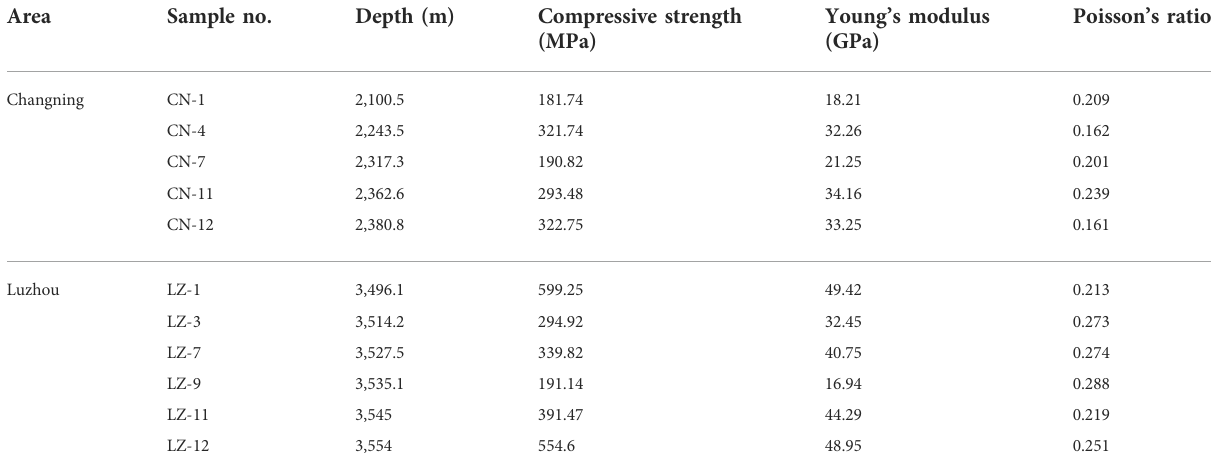
TABLE 2 Test results of triaxial compression experiments of the longmaxi formation shale in the study area. Area Sample no.